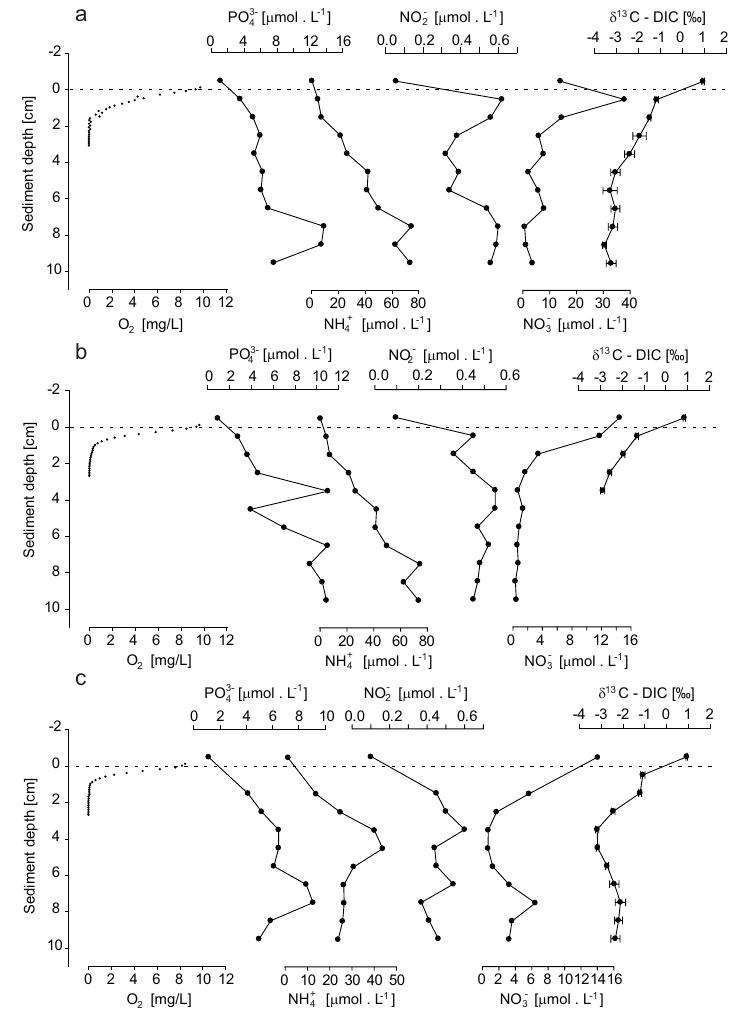
Fig. 4. Oxygen microprofiles and pore water results vs. depth at station 1 (a) , 2 (b) and 3 (c) .